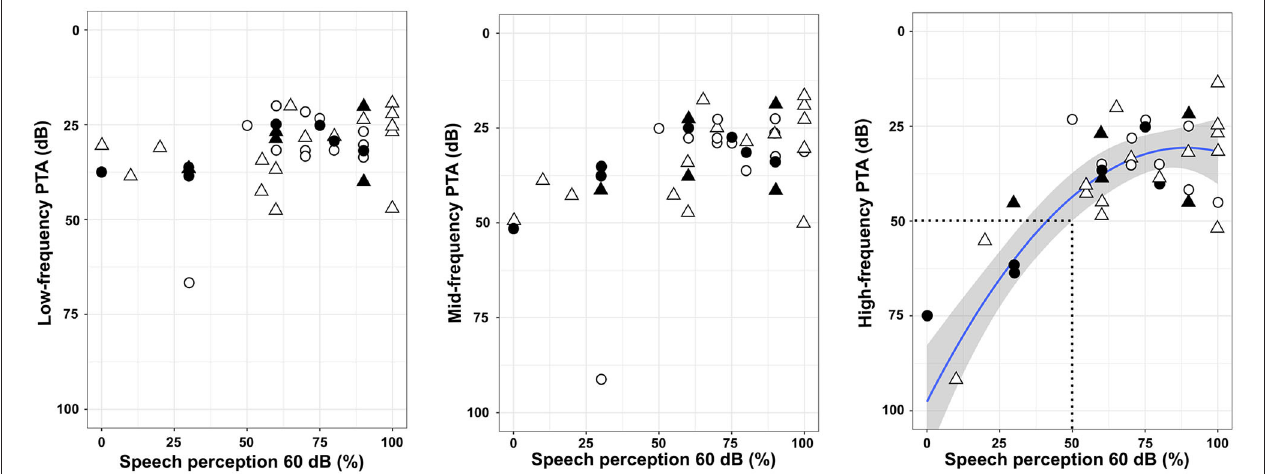
FIGURE 3 | Speech perception at 60 dB in silence and pure-tone audiometry thresholds. The line represents a non-linear regression [ f ( x ) = 0.008x 2 -0.38x + 35.1, p < 0.0001; Adjusted R 2 = 0.64], and the gray zone represents the 95% confidence interval. The area within the dotted lines indicates a poor speech perception lower than 50% and a high-frequency PTA higher than 50 dB. Triangles: robot-assisted insertion; circles: manual insertion; filled symbols: translocation of the electrode array; unfilled symbols: non-translocation.